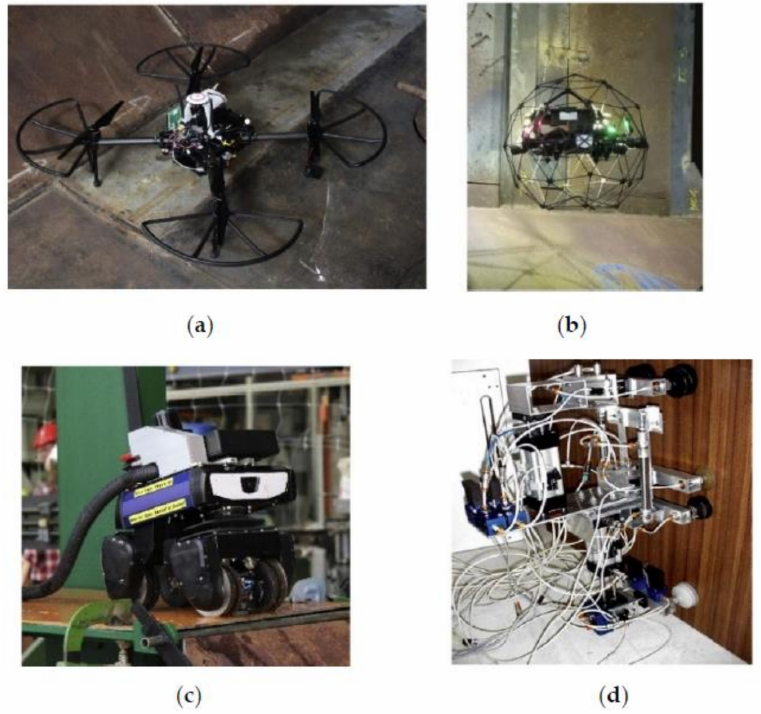
Figure 27. RAS platforms: ( a ) UIB drone, ( b ) FLY drone, ( c ) GEIR crawler, and ( d ) zoomorphic robot